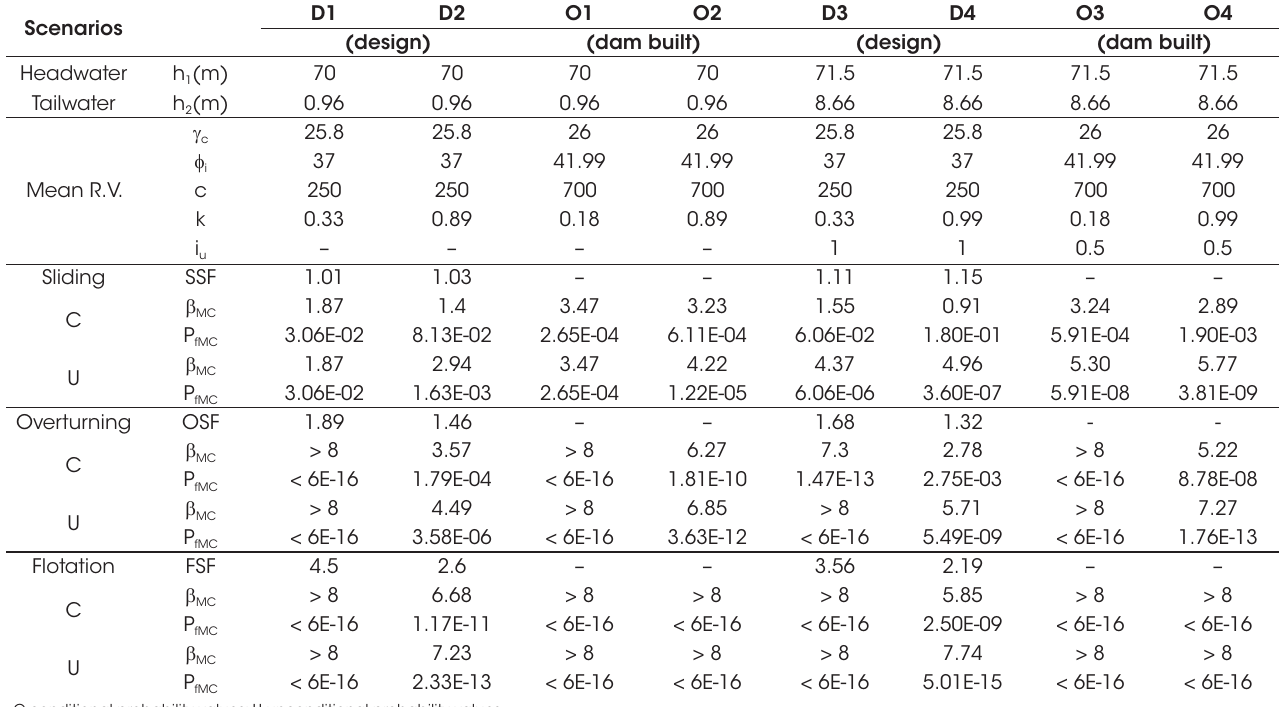
Values of ( β ) e (P